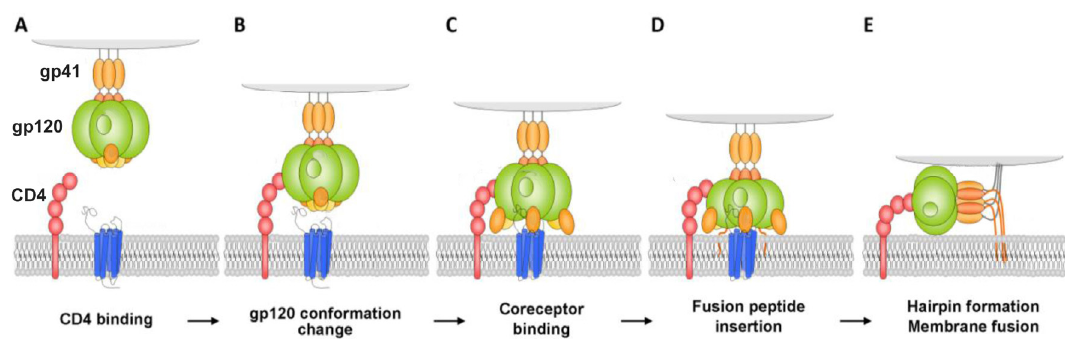
Figure 1. The structure of the HIV virion [8].